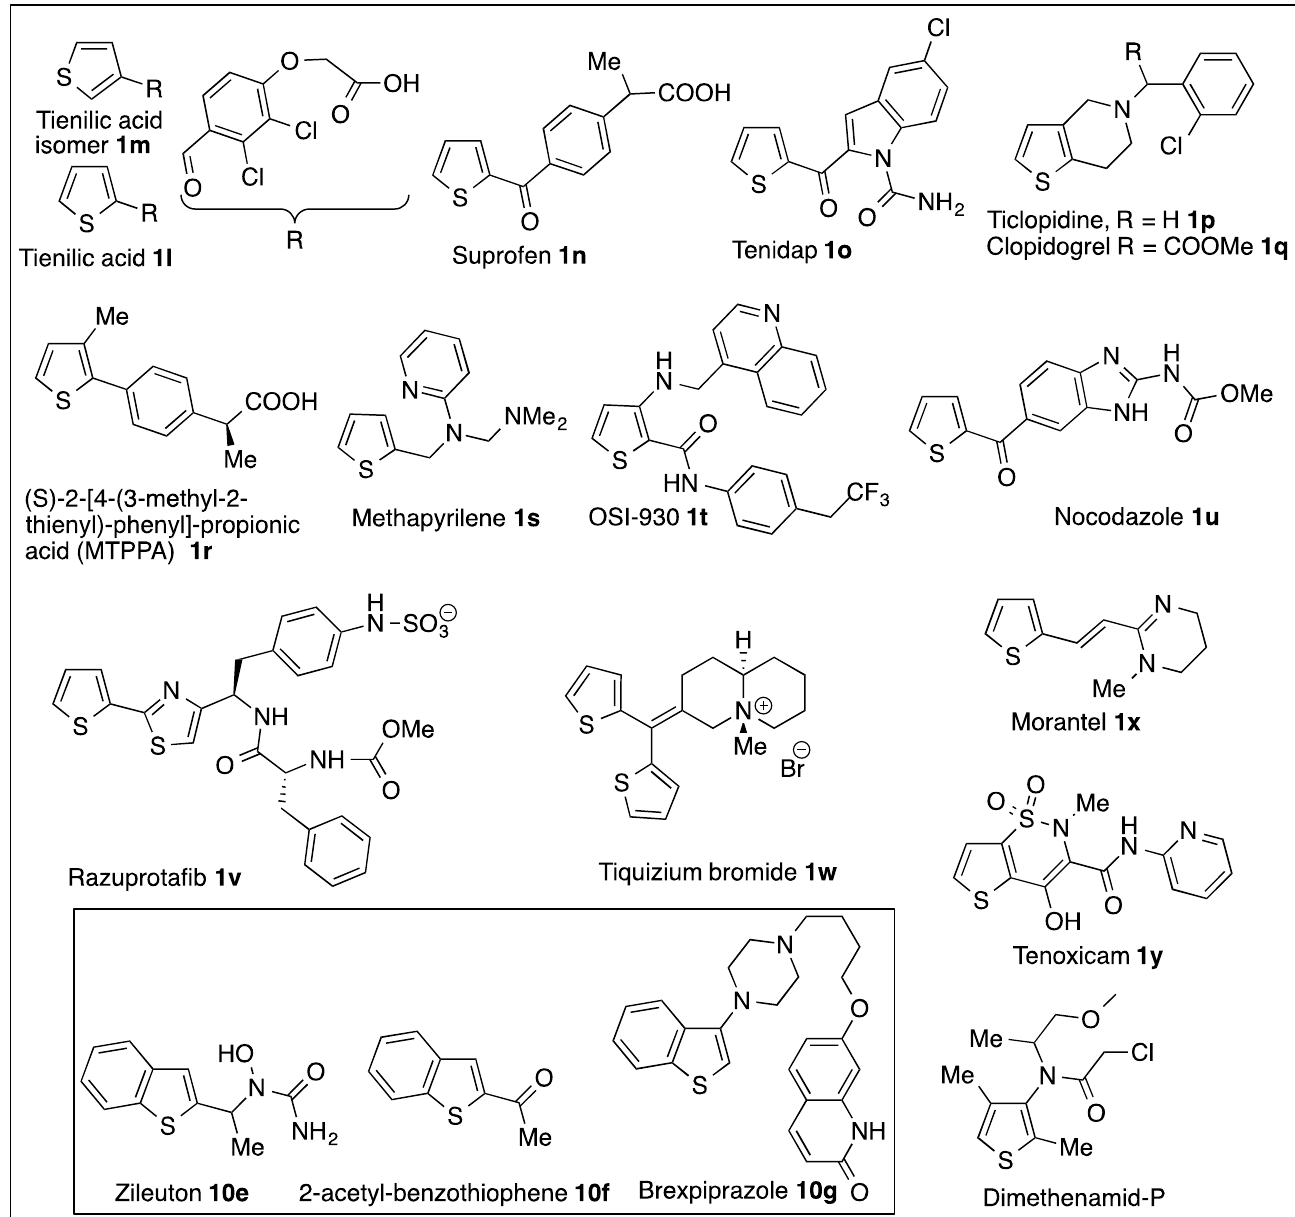
Figure 5. Thiophene- and benzothiophene-containing drugs and analogs tested in metabolic stud-